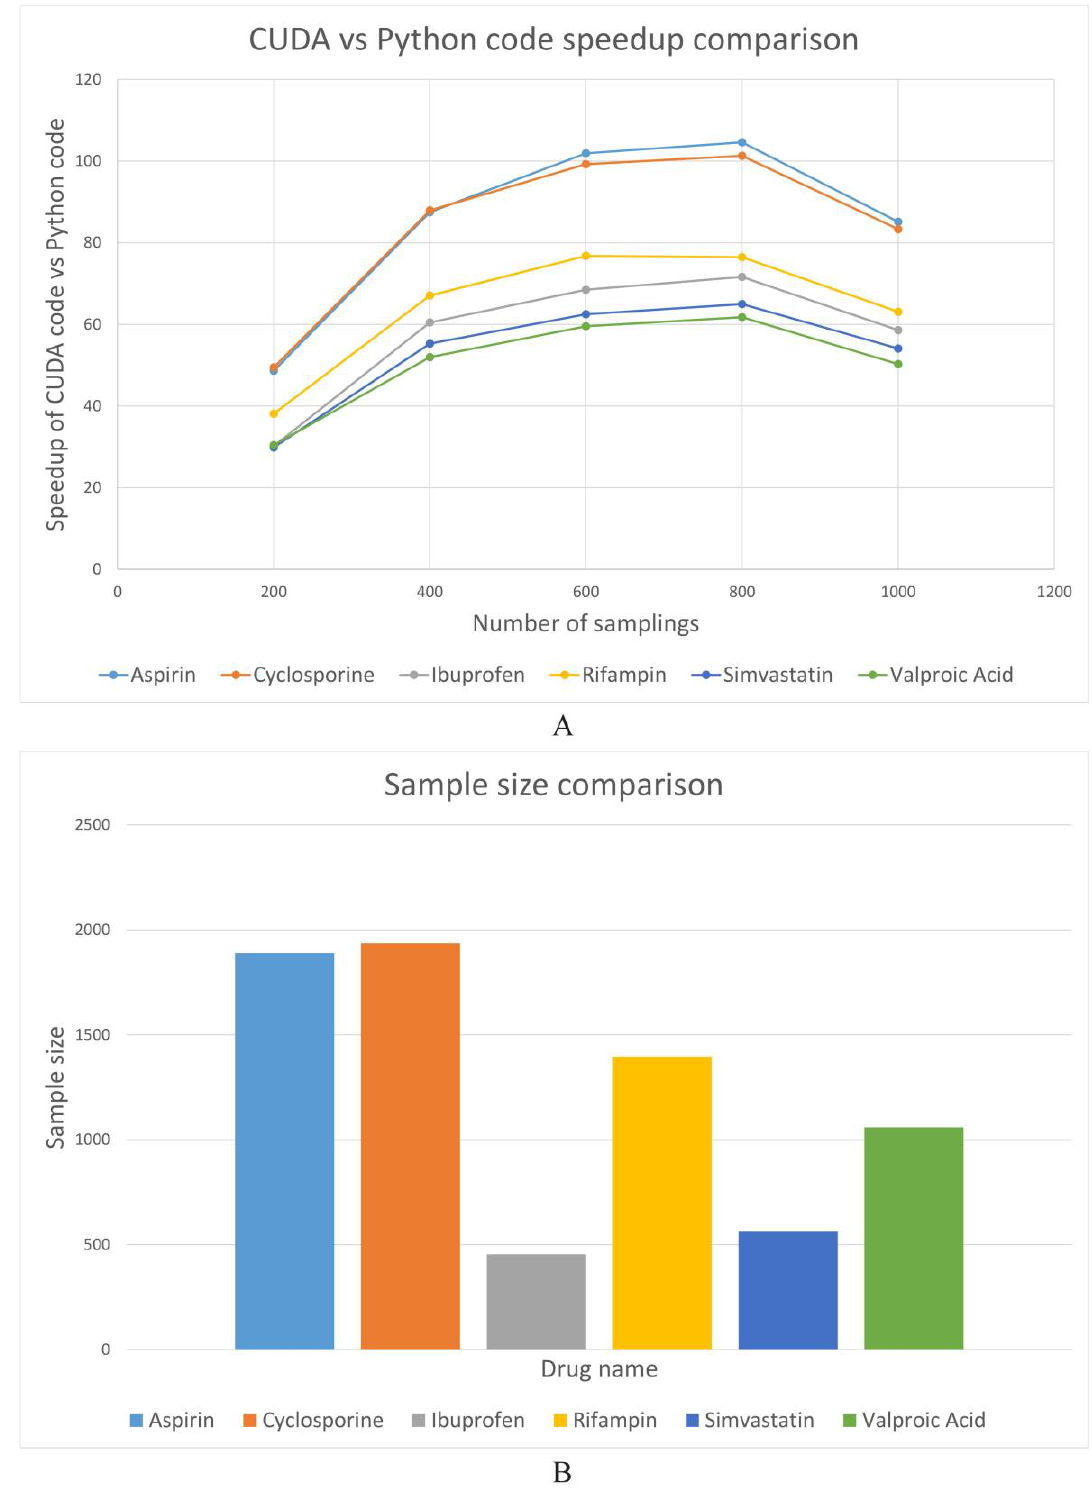
Figure 2. ( A ) The comparison of the speedup of the compute unified device architecture (CUDA) vs. Python code for different threads across six drugs. ( B ) The comparison of sample size for six drugs.